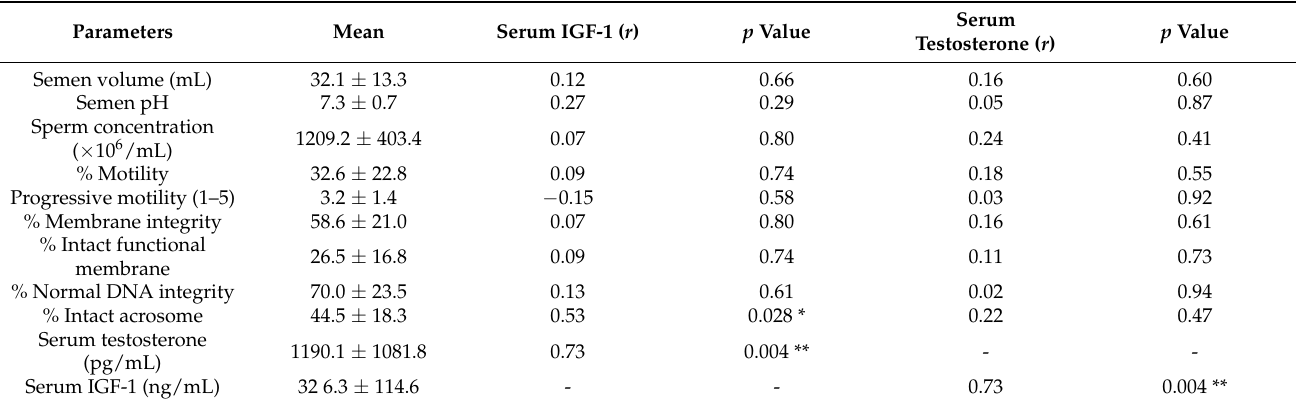
mean values ( ± SD ) of seven elephant bulls.